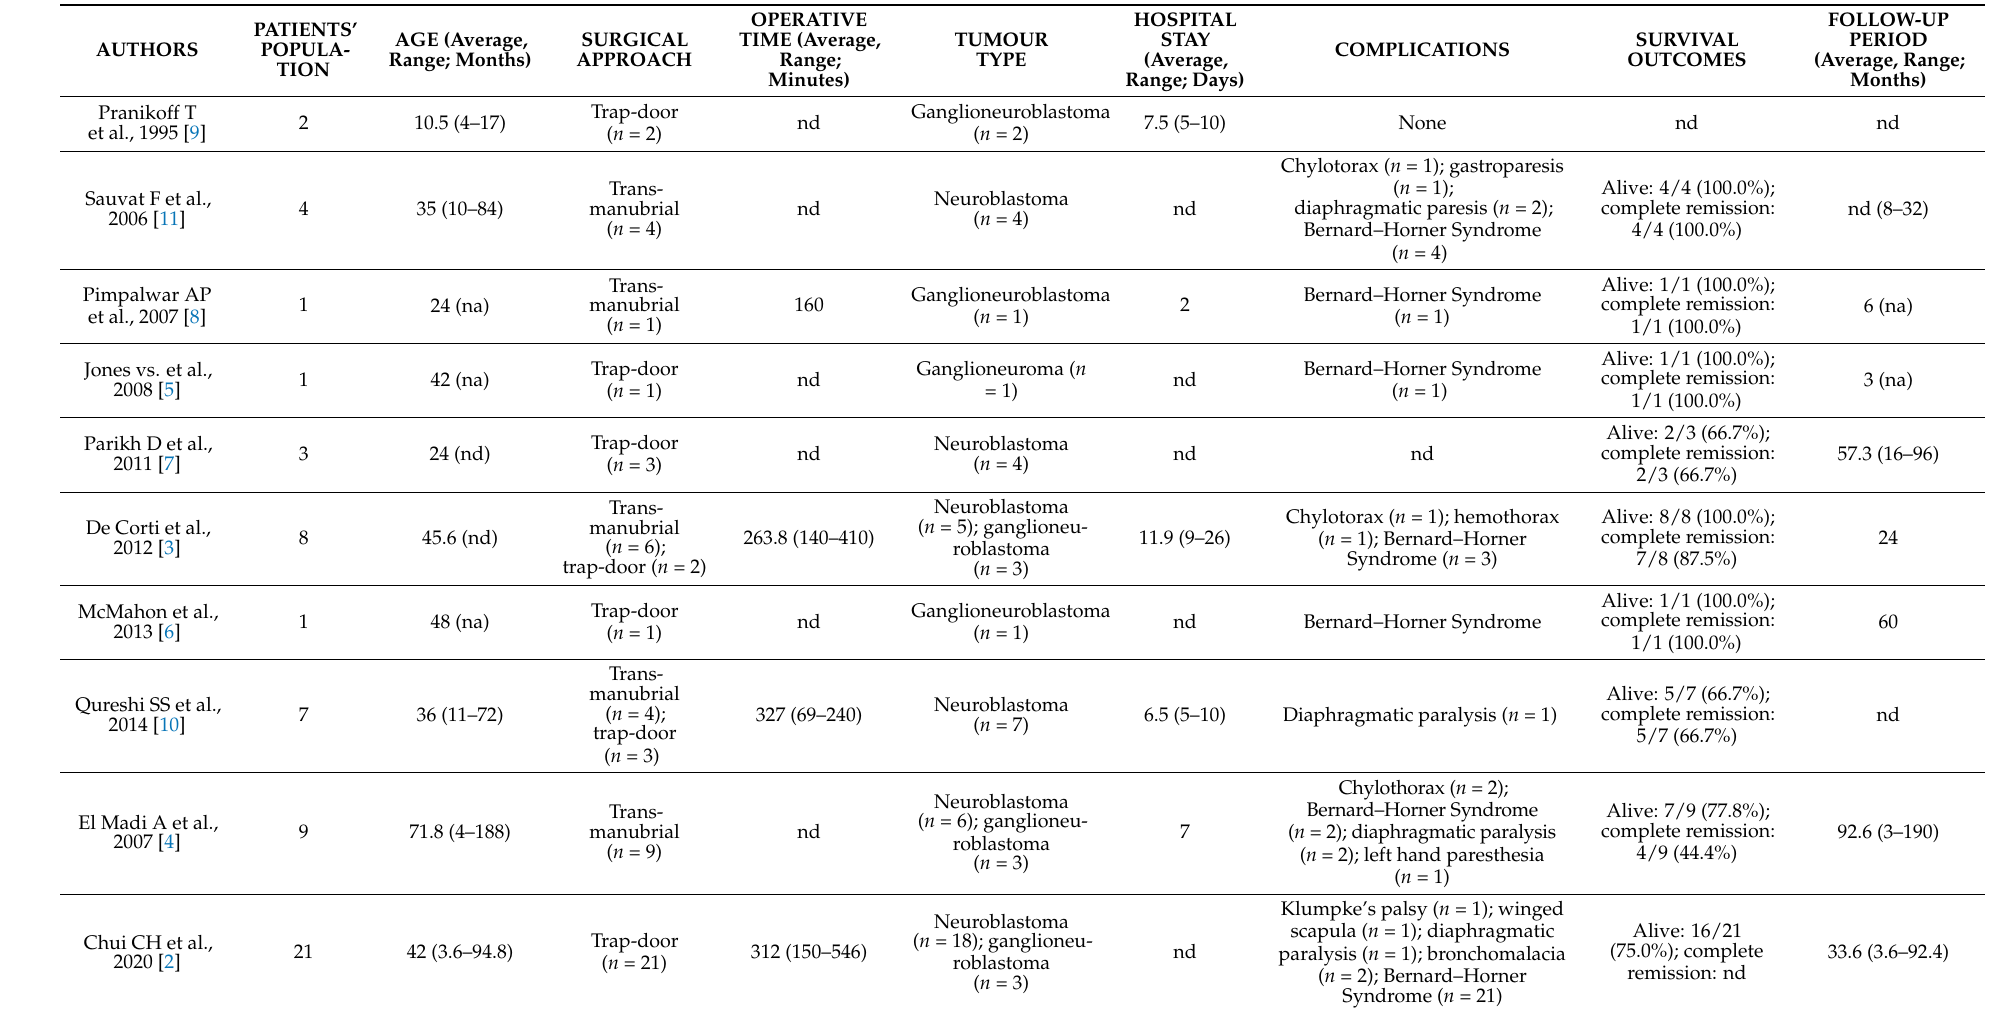
Table 2. Main articles reporting the surgical experience with cervicothoracic neuroblastomas in